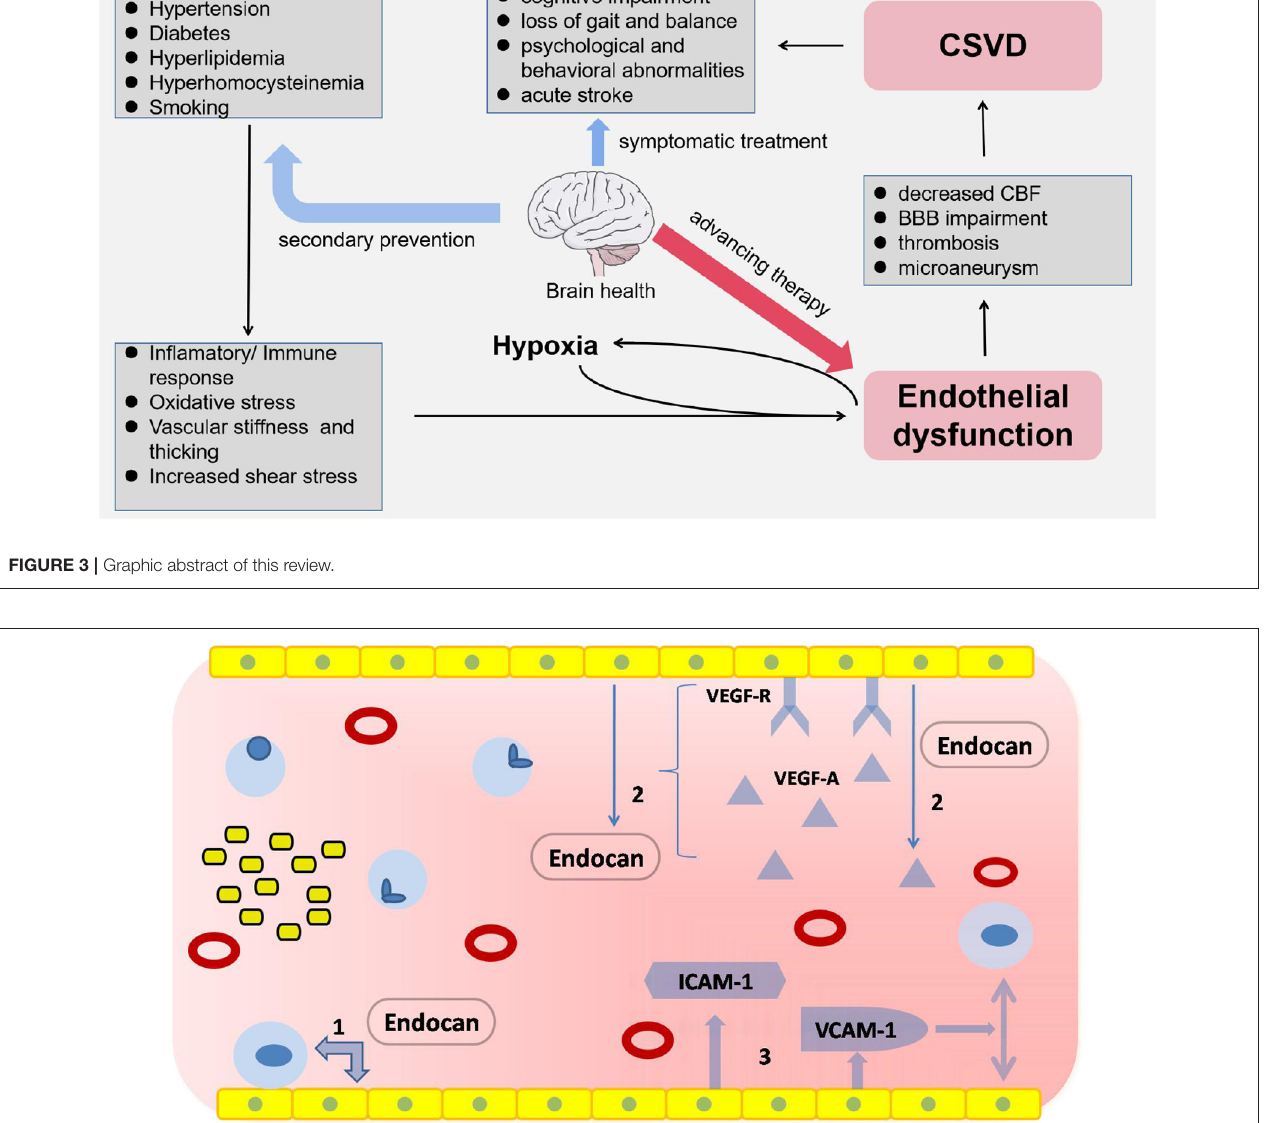
FIGURE 4 | Physiological functions of Endocan. The yellow squares at the upper or lower edges represent ECs, which form vascular endothelium by tight junctions; the red hollow circles represent red blood cells; the light blue circles represent leukocytes; the yellow squares with black borders represent platelets. (1) Endocan regulates the interaction between ECs and leukocytes. (2) Endocan promotes the expression of vascular endothelial growth factor-A (VEGF-A) and enhances the binding of VEGF-A to its receptors. The activation of a VEGF signaling pathway contributes to the production of Endocan. (3) Endocan promotes the release of pro-inflammatory